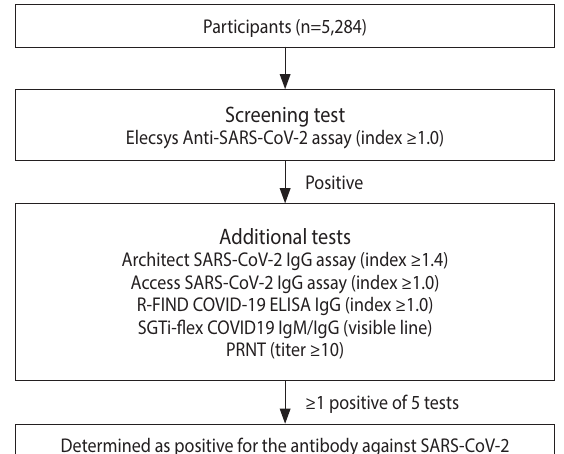
Figure 1. Criteria of severe acute respiratory syndrome coronavi- rus 2 (SARS-CoV-2) antibody positivity determination. Total 5,284 blood samples of participants were screened using Elecsys Anti- SARS-CoV-2 assay. If the result was positive, five additional anti- body tests, including plaque reduction neutralizing test (PRNT), were performed. If one of the five assays was positive, the sample was considered positive for the antibody against